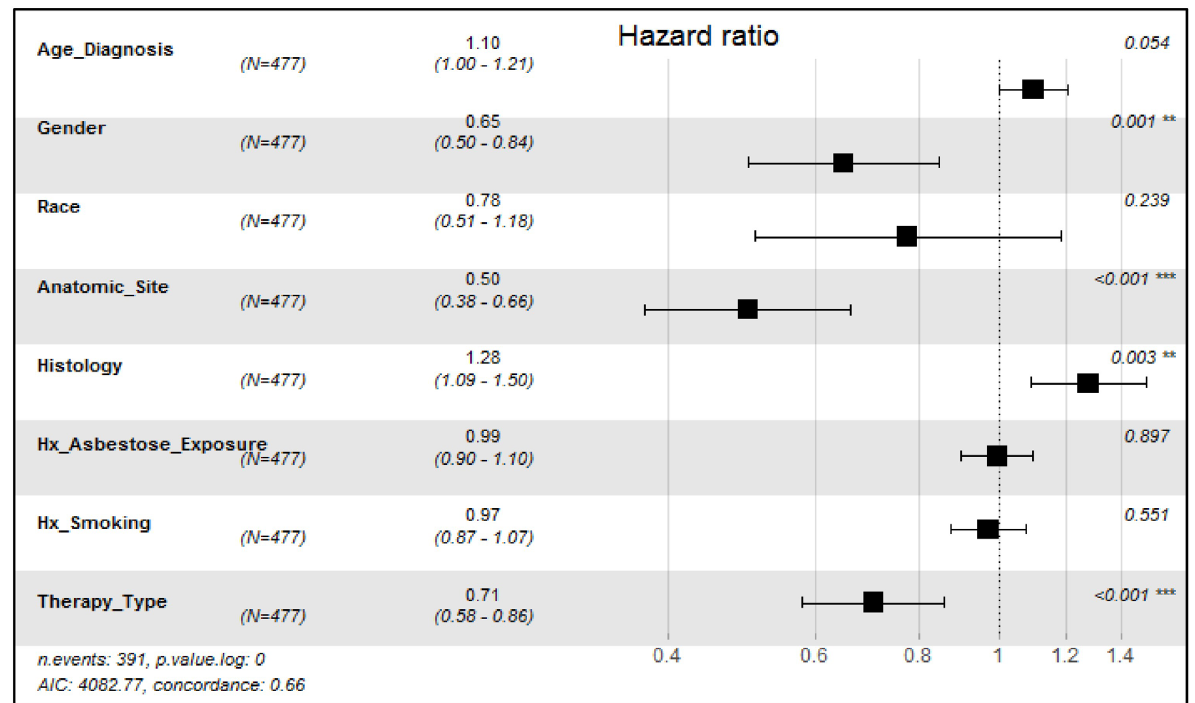
Figure 3. Adjusted Cox Hazard analysis, predictors of mesothelioma survival, multivariable analysis